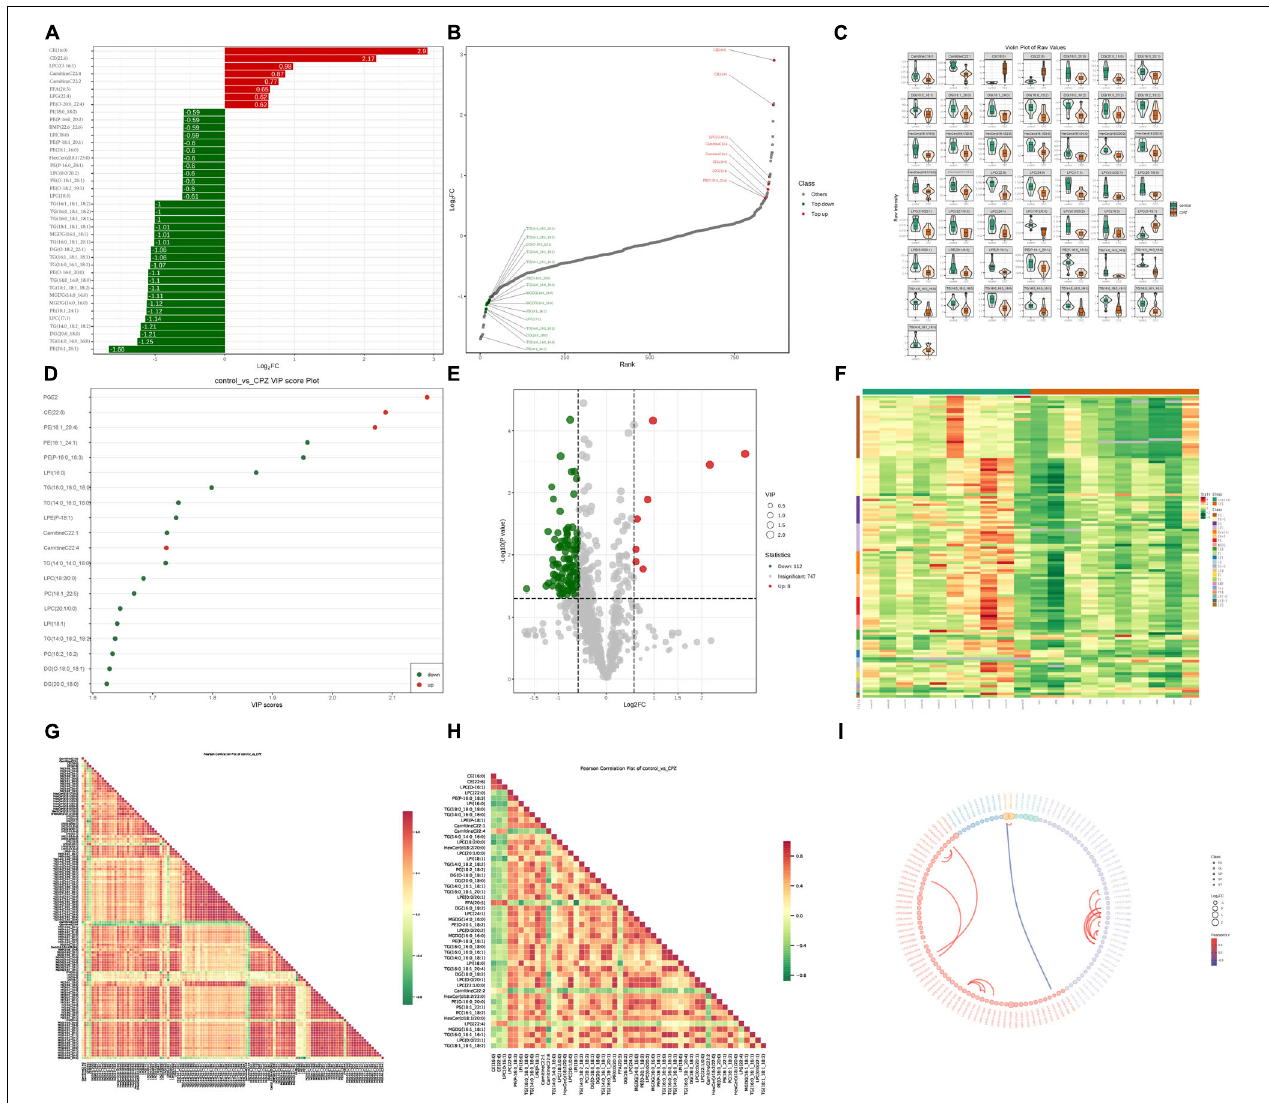
FIGURE 5 | (A) Metabolite bar graph. (B) Dynamic distribution of metabolite content differences. (C) Metabolite violin diagram. (D) Metabolite VIP value chart. (E) Volcano Plot of metabolites. (F) Metabolite clustering heat map. (G) Heat map of the correlation of the all-differential metabolites. (H) Heat map of the correlation of the top 50 differential metabolites. (I) Differential metabolite chord